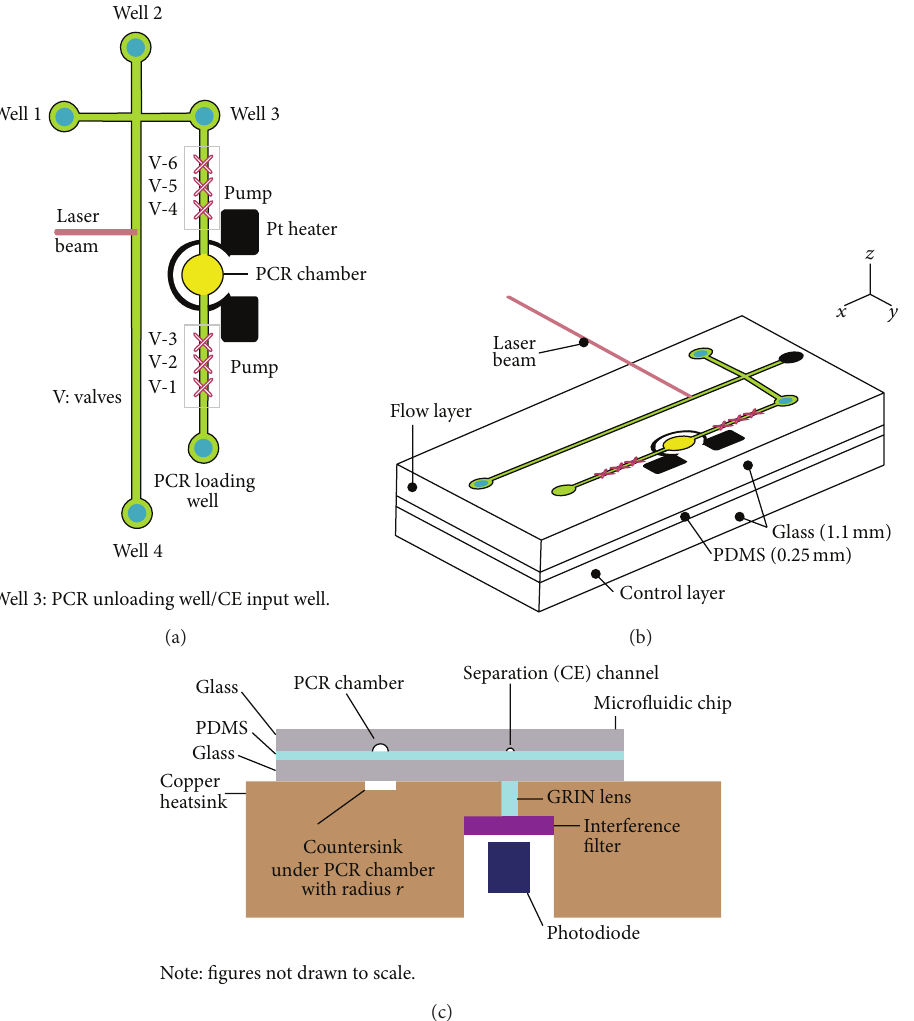
Figure 2: The modelled PCR-LOC device. On (a) a schematic of the chip, showing the PCR chamber as a yellow circle. The chamber is surrounded by the heater ring. The squares in the middle are the heater contact pads. The crossing channels form the CE section. On (b) a 3D view of the chip showing the three layers that comprise the device. On (c) a cross-section view of the chip showing the chip placed on the heatsink that provides passive cooling